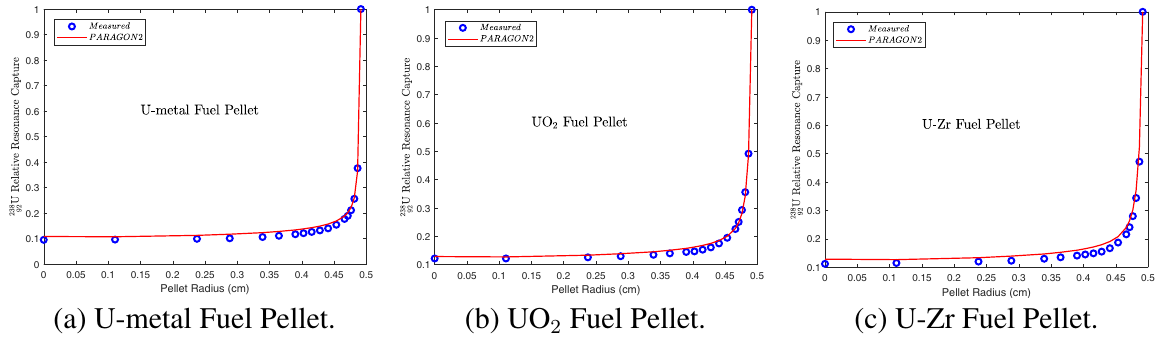
Figure 2: TRX Experiment - U238 Spatial Resonance Capture